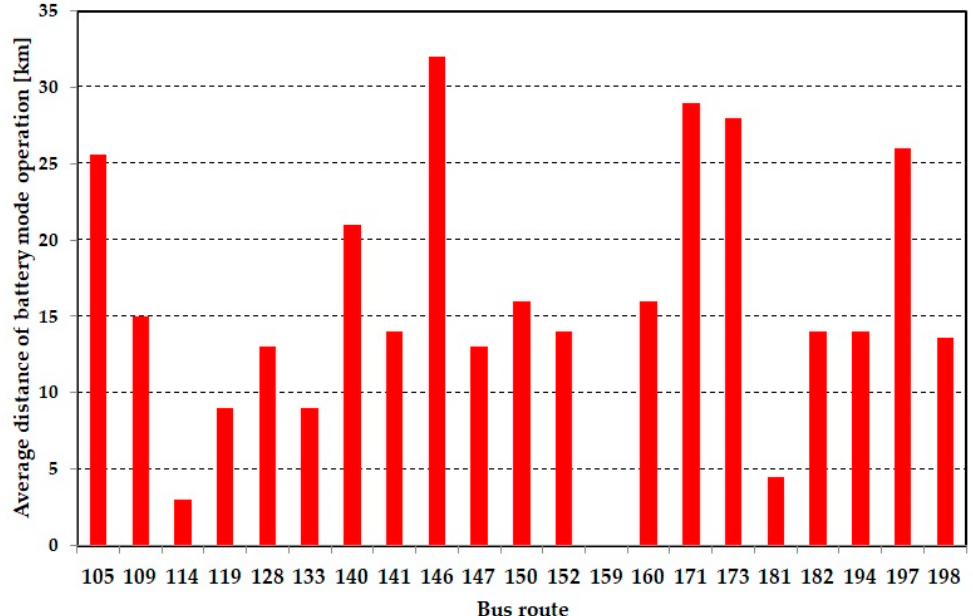
Figure 13. Maximum driving range on battery operation (source: own elaboration).